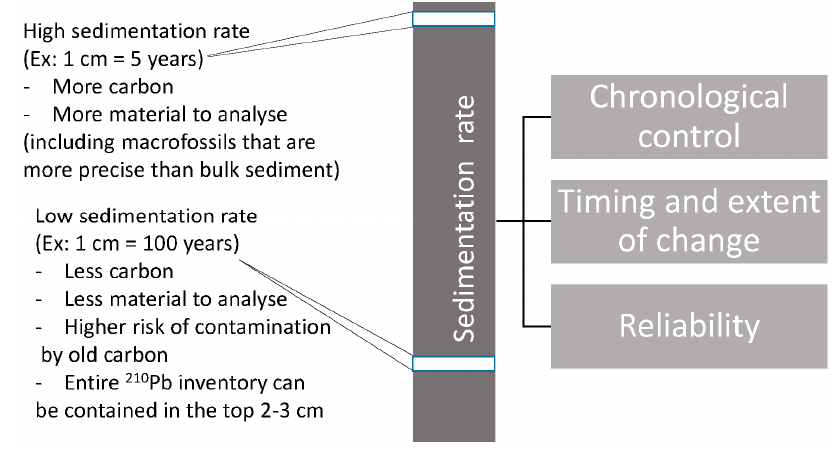
Figure 1. Sediment core chronologies ranging from around 500–45,000 years BP are most often generated using the 14 C method. Since organic matter is needed for this method, lake sediments that contain very small amounts of organic carbon are likely to be problematic to date (see [18]). In less productive lakes, where small accumulations can represent long periods of time (sometimes a few centuries in 1 cm), short-lived changes can easily go unnoticed. Dating more recent sediments (<150 years) is done using the degradation of 210 Pb in the upper section of the core, but it remains difficult to obtain reliable dates between around 150–500 years